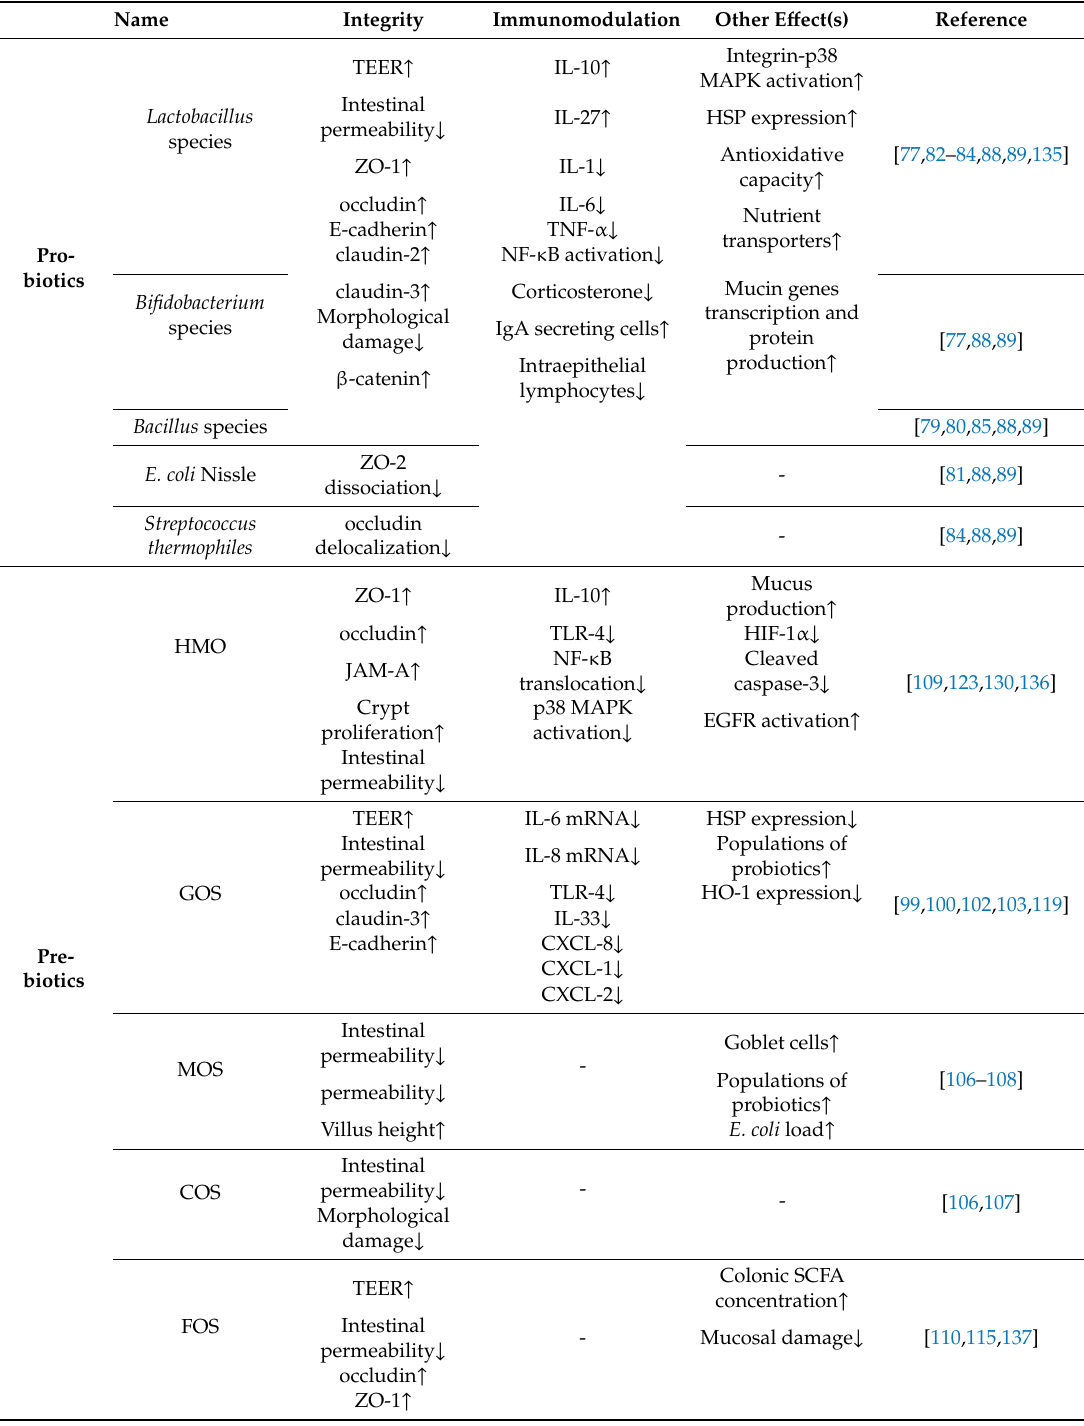
Table 1. The e ff ects of pro- / prebiotics on intestinal integrity and